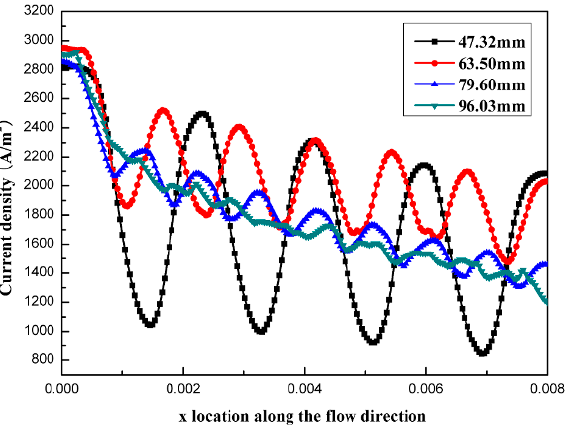
Figure 9. Current density distributions at the catalyst layers along the x direction under the conditions of different open ratios.